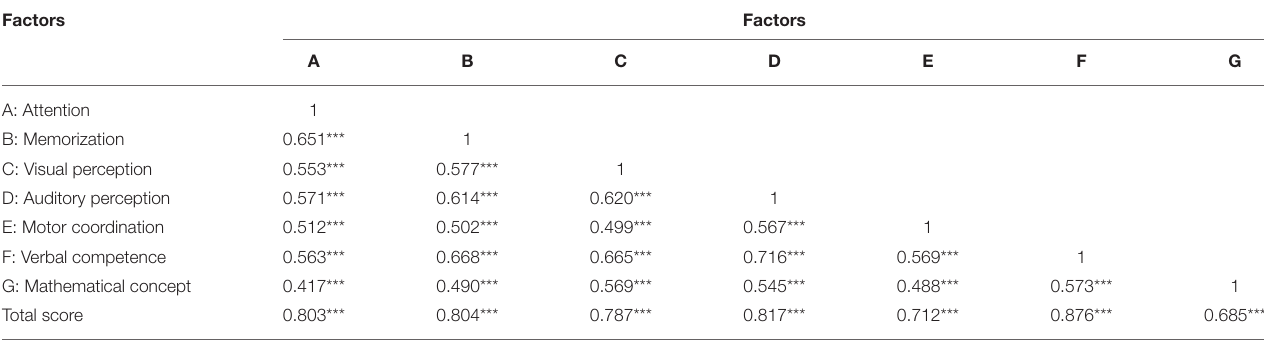
TABLE 4 | Spearman correlations of interfactor and factor-total score ( n = 1,540).